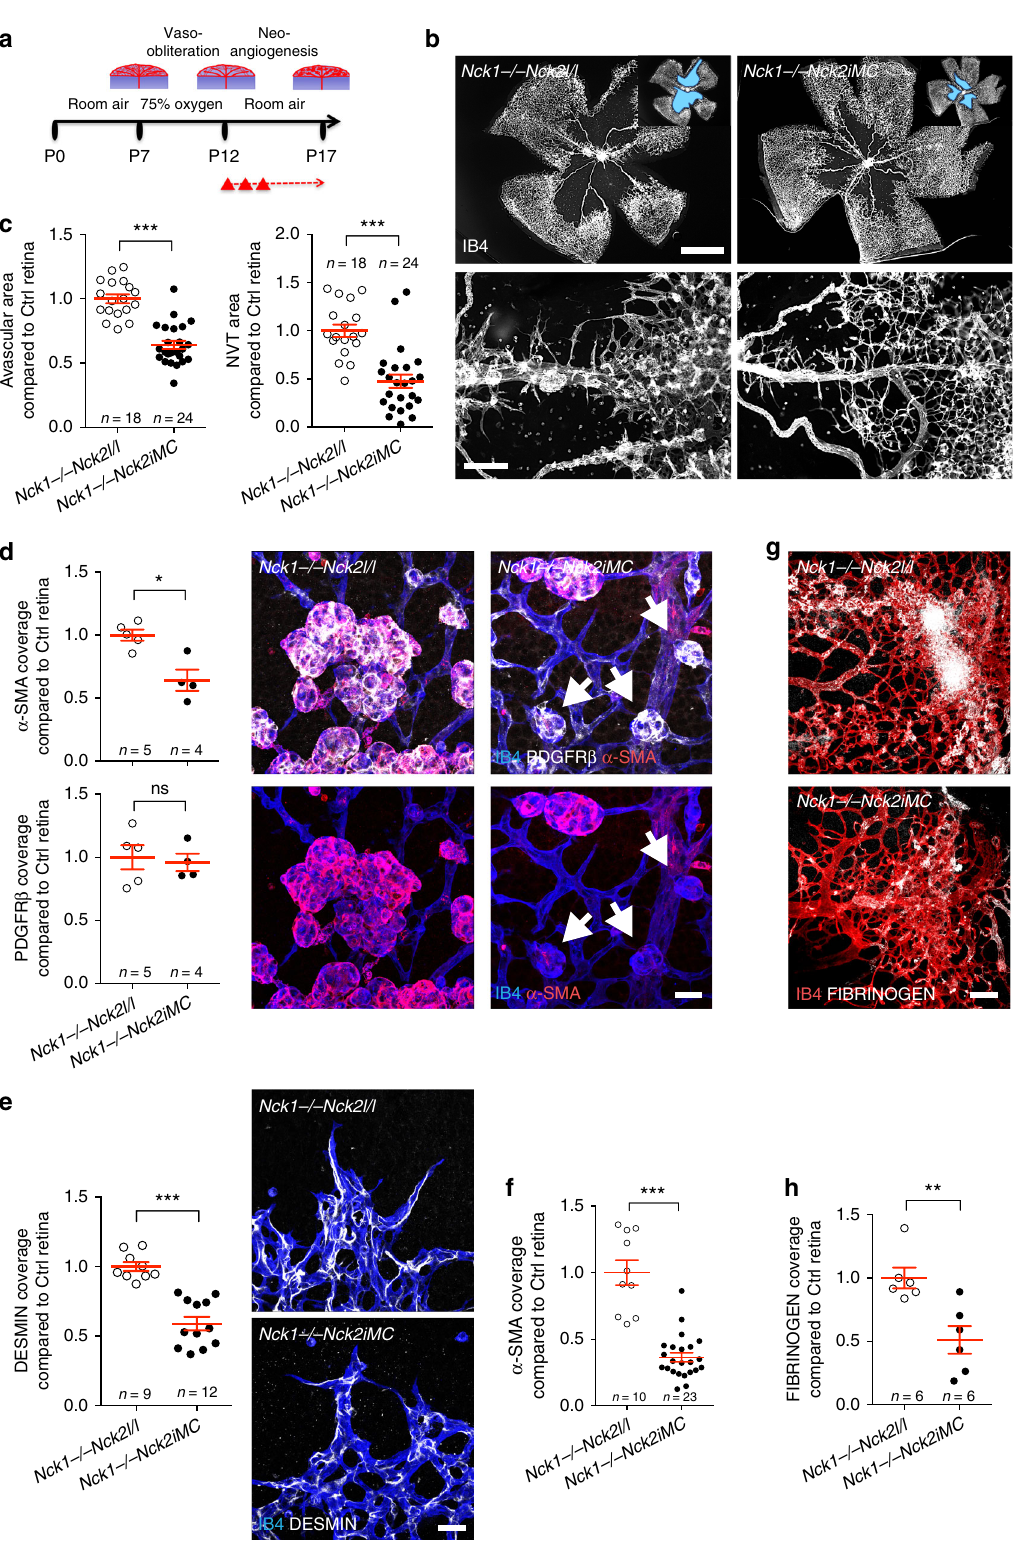
tested using Mann – Whitney U test or two-tailed Student ’ s t test between groups. P value 0.05 was considered to be statistically signi fi cant. Statistical analyses